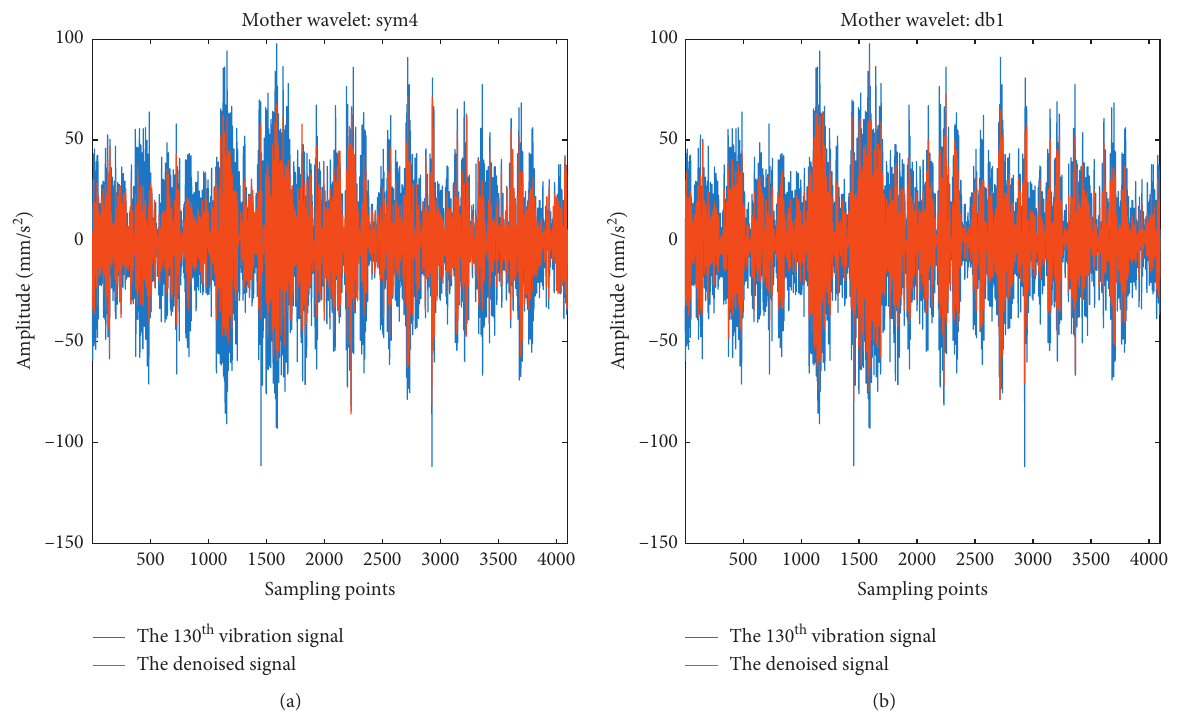
Figure 8: Comparisons of the wavelet denoising based on sym4 and db1 mother